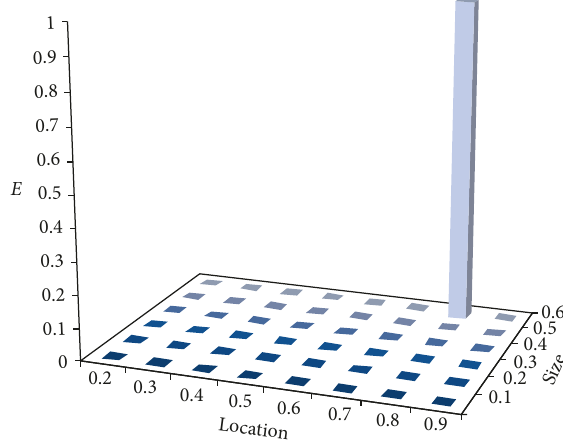
Figure 10: Damage index for the second crack of a multicracked [1386] composite beam with no measured errors.